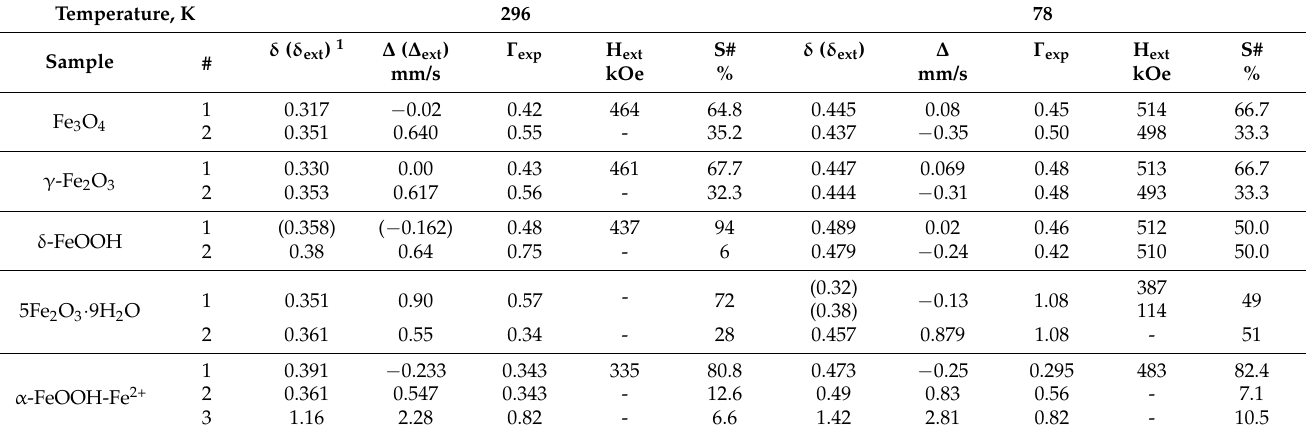
Table 2. Results of non-model description of the Mössbauer spectra of